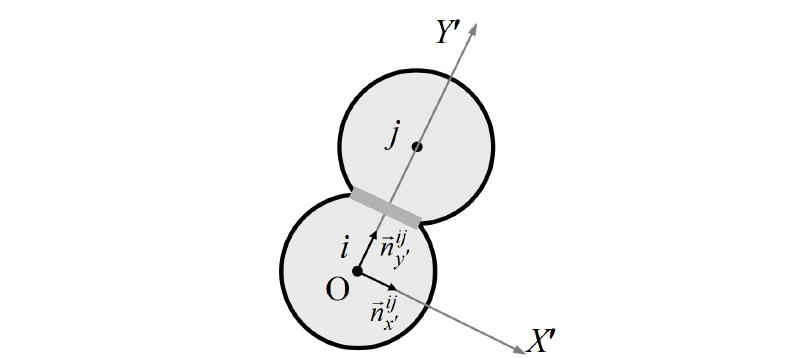
Figure 7: Instantaneous coordinate system X  Y  associated with the current spatial orientation of the pair i-j